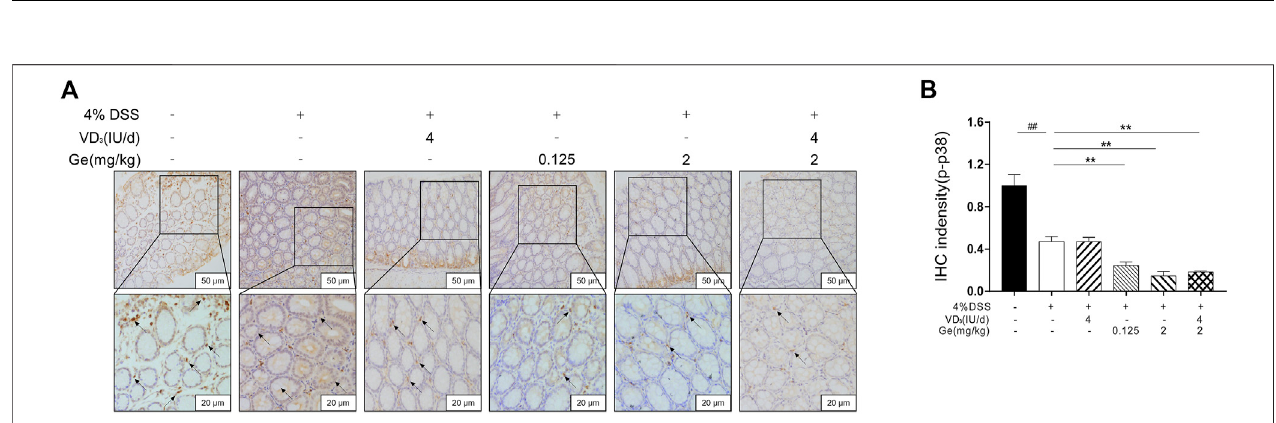
FIGURE 4 | Geniposide inhibited the expression of activated p38 MAPK. (A) Representative p-p38 MAPK expression in each group (200 × and 400 × ); (B) IHC intensity of p-p38 MAPK. ## p < 0.01, vs. the normal control group; ** p < 0.01, vs. the model control group. n (cid:1) 6 per each group.